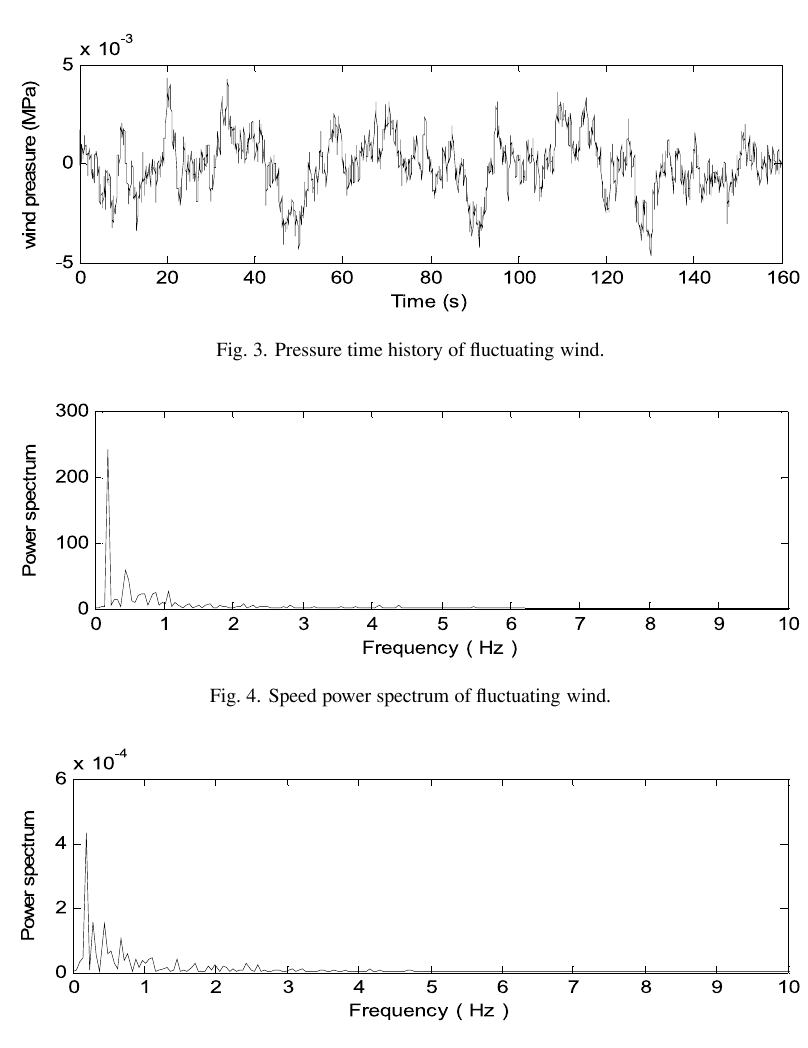
Fig. 5. Pressure power spectrum of fl uctuating